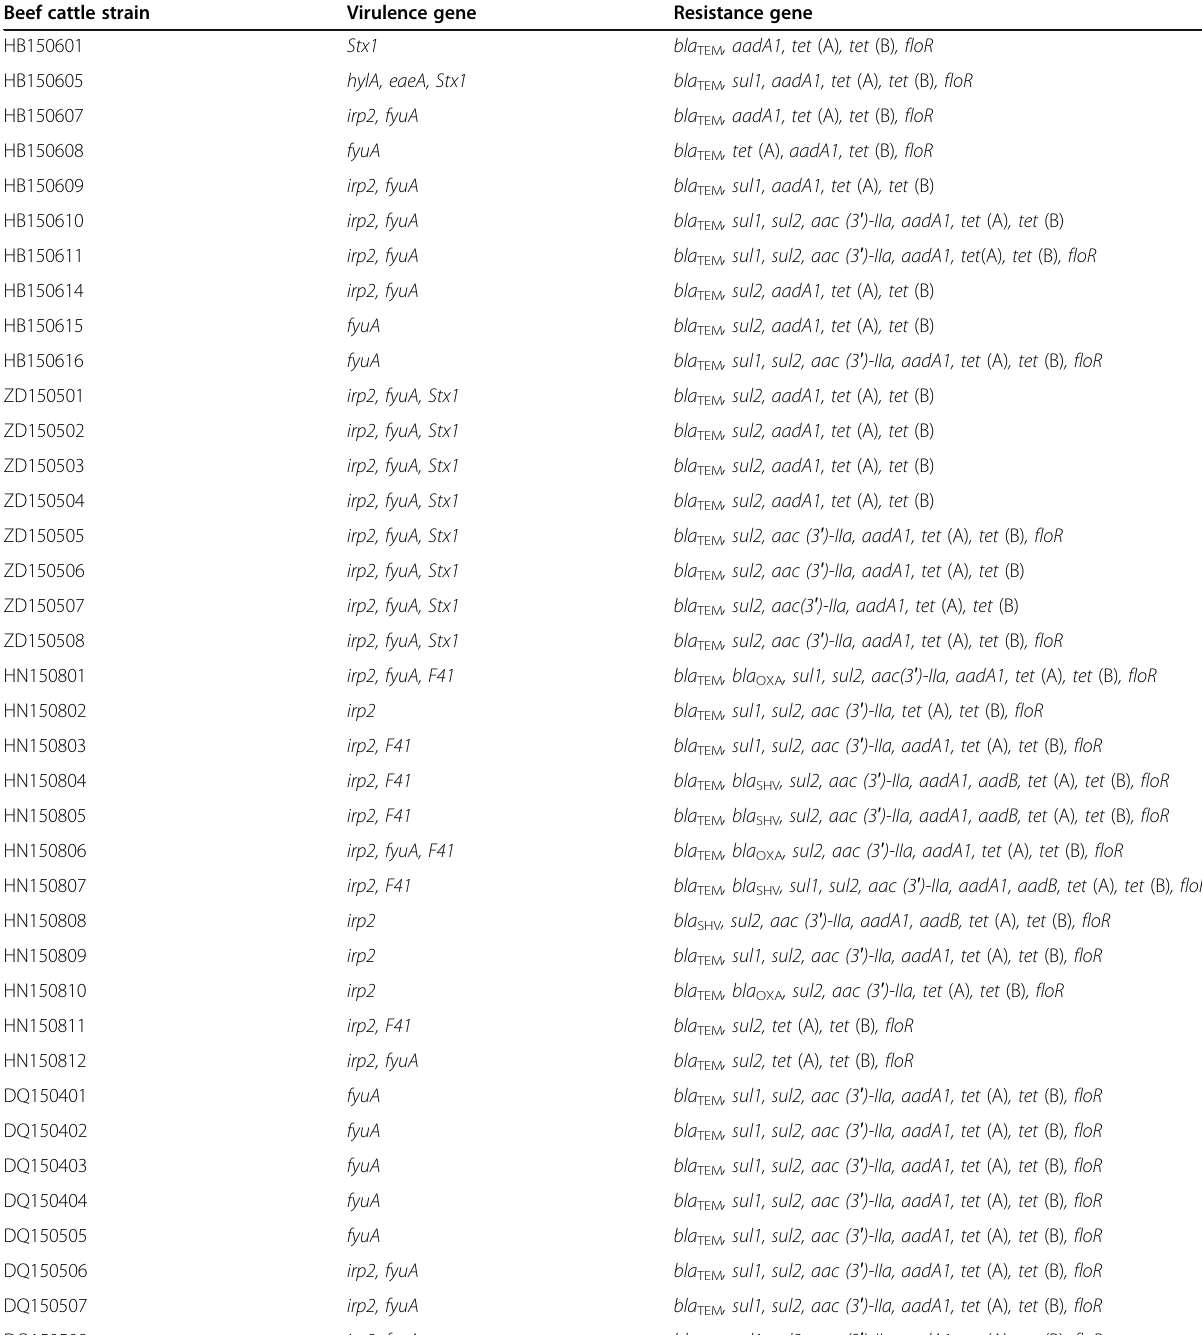
Table 5 Beef cattle E. coli resistance genes and virulence genes Beef cattle strain Virulence gene Resistance